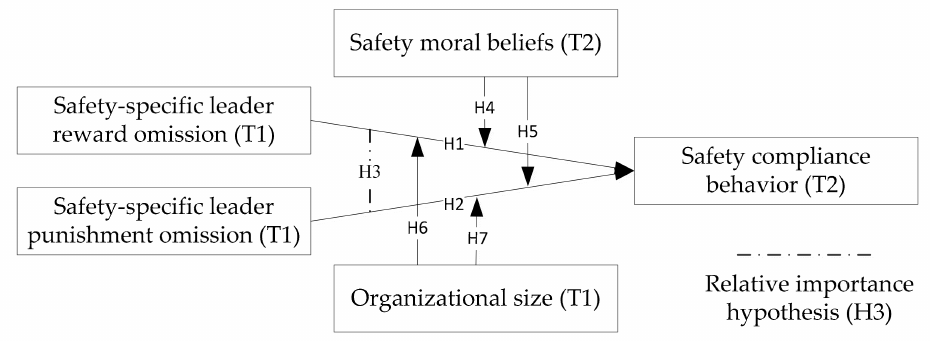
Figure 1. Relations among research variables according to hypotheses. Note: T1 and T2 represent the first and second wave data collection,